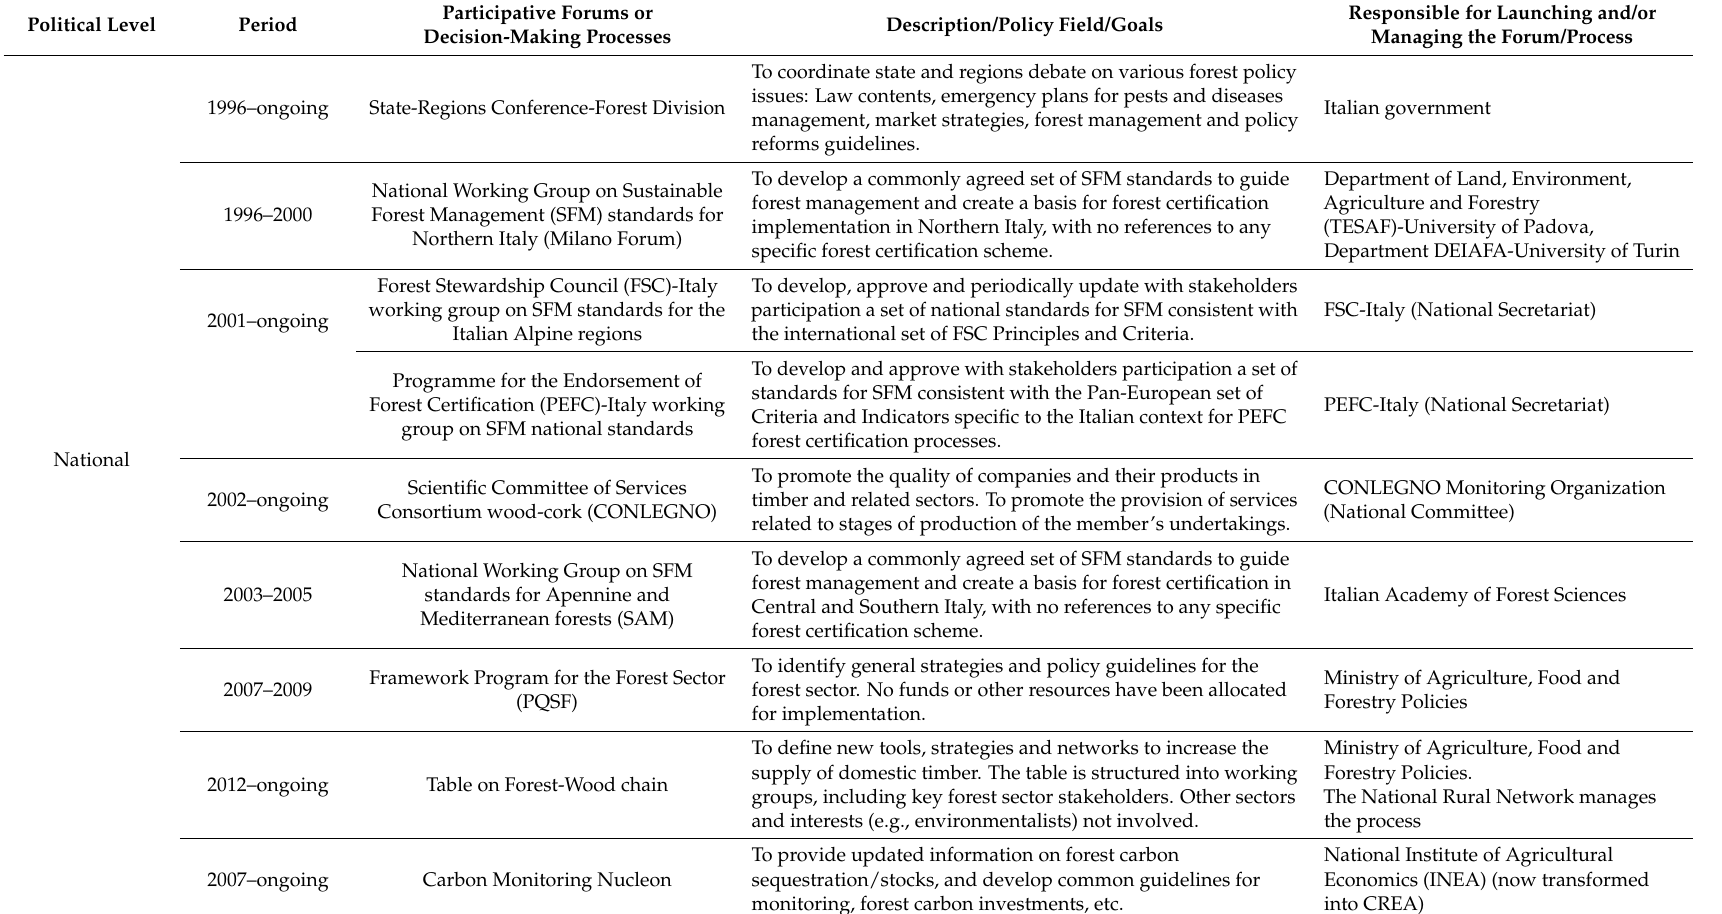
Table 2. Examples of forest-related participatory forums in Italy, at different